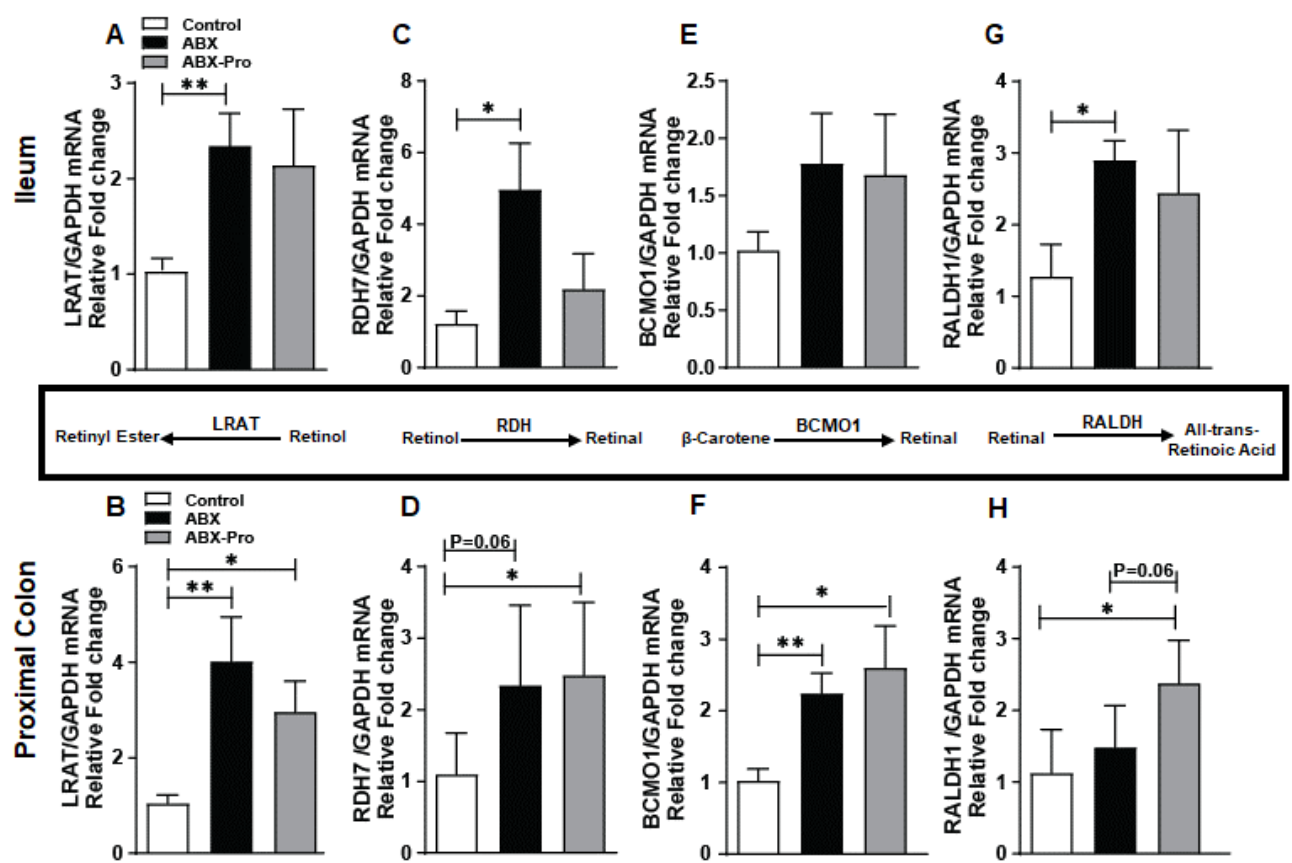
Figure 5. Vitamin A Metabolism. Mice were treated as described in Figure 1. At euthanasia, ileum and proximal colon were dissected and relative mRNA expression of ( A , B ) LRAT, ( C , D ) RDH7, ( E , F ) BCMO1, and ( G , H ) RALDH1 was detected by qRT-PCR. Values represent mean fold change from control mice ± standard error of the mean. * p < 0.05, ** p < 0.01. The enzyme retinol dehydrogenase 7 (RDH7) converts retinol to retinal. In the